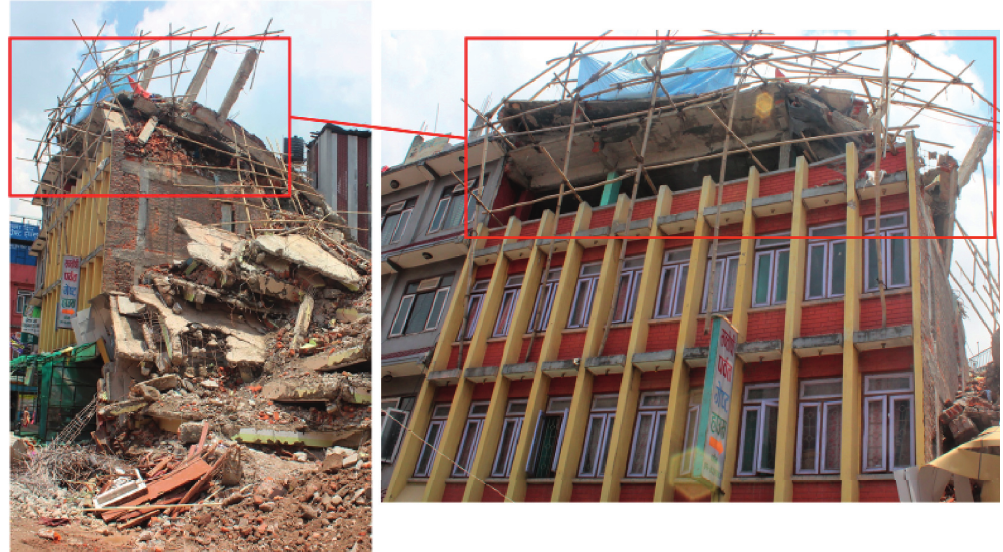
Figure 6: Collapsed top story in a soft-story building in Kathmandu by the Gorkha